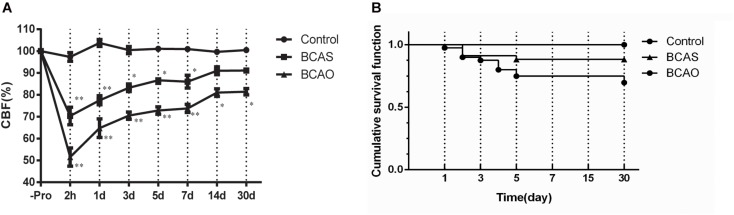
The survival rates (A) and CBF values (B) in each group after surgery. The data are presented as the mean ± SD and expressed as percentages of the preoperative value. *P < 0.05 and **P < 0.01 compared with the control group using Dunnett’s multiple comparison test. CBF, cerebral blood flow; BCAS, bilateral common carotid artery stenosis; BCAO, bilateral common carotid artery occlusion; SD, standard deviation.